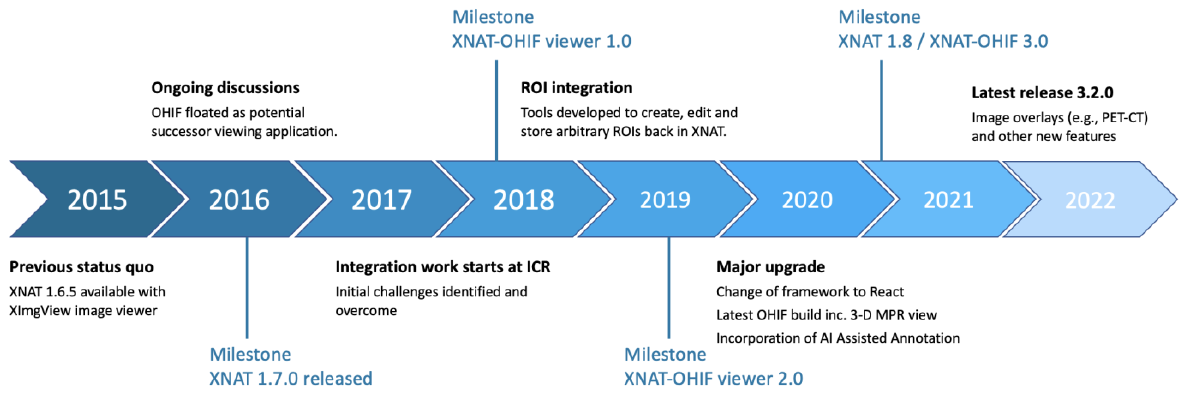
Figure 1. ICR-XNAT-OHIF viewer development project timeline.